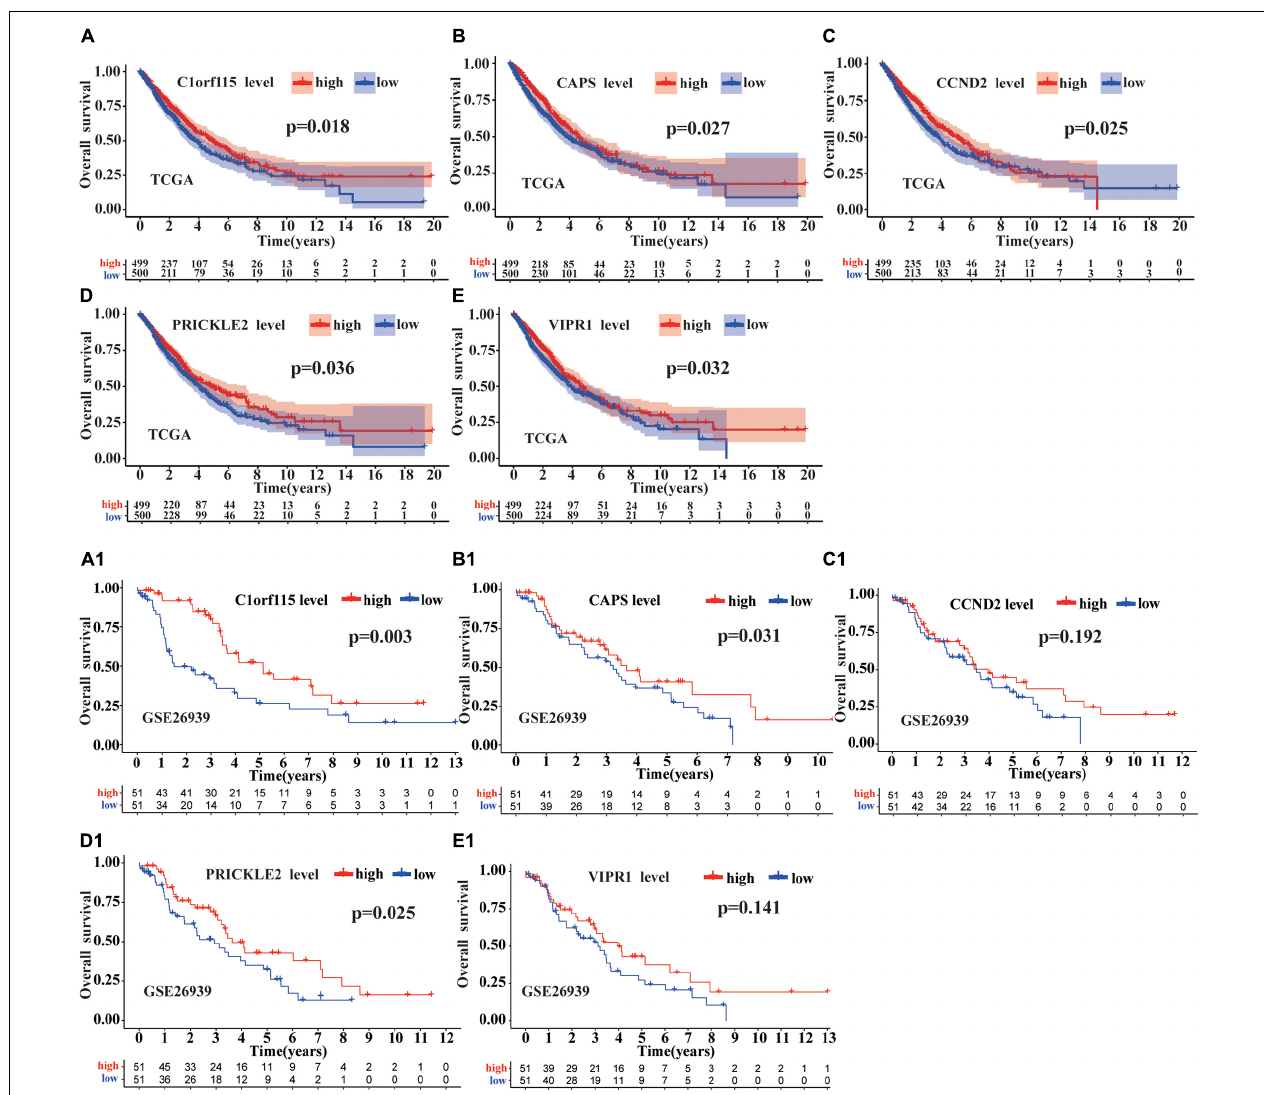
FIGURE 7 | Survival analysis of mRNAs in ceRNA regulatory network. The survival prognosis of 22 mRNAs was analyzed based on the TCGA database. As shown in (A) , compared with the group with low C1orf115 expression, the group with high C1orf115 expression had a better prognosis in LUAD ( p = 0.018). As displayed in Panels (B–E) , we have reached the same conclusion for CAPS, CCND2, PRICKLE2, and VIPR1 ( p = 0.027, p = 0.025, p = 0.036, and p = 0.032). As depicted in (A1), (B1), (C1), (D1), and (E1) , based on GSE26939 array from the GEO database, only C1orf115, CAPS, and PRICKLE2 ( p = 0.003, p = 0.031, and p = 0.025) have been verified to be consistent with the above